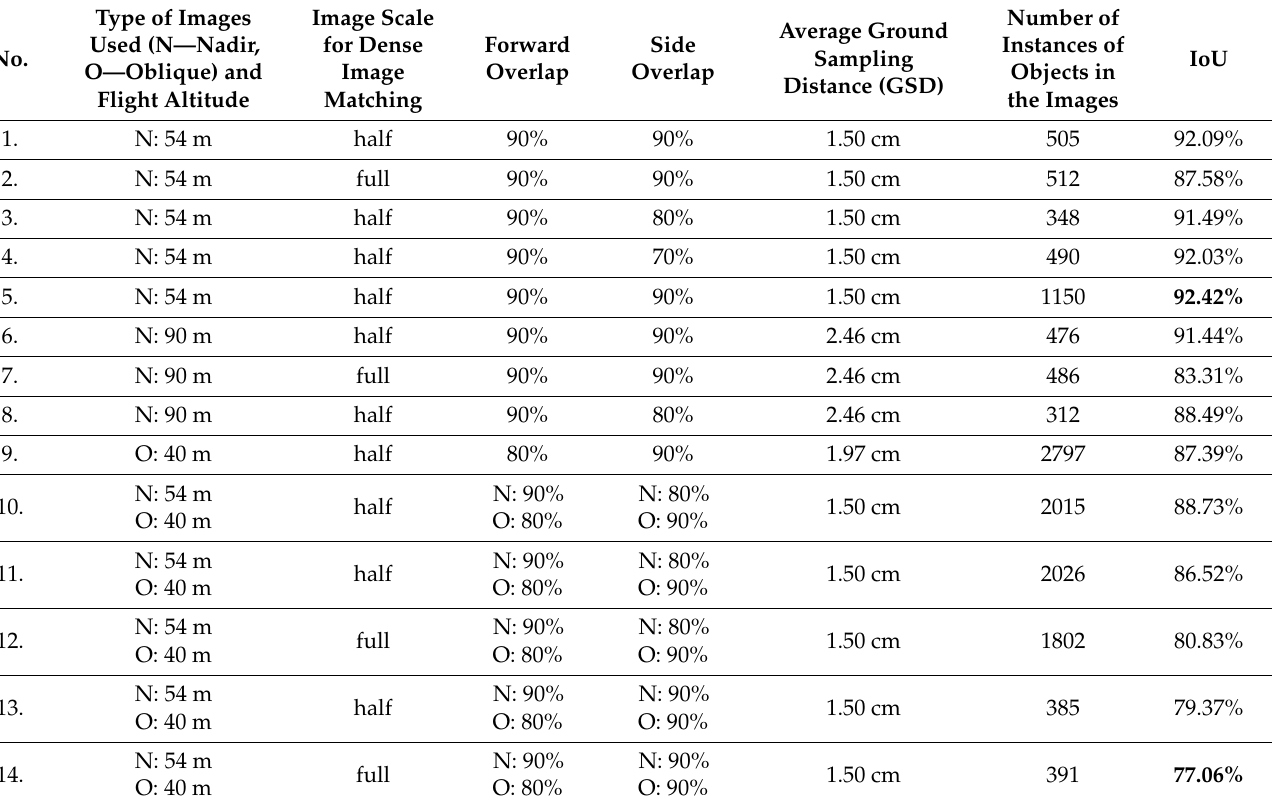
Table 7. Accuracies of the resulting bounding boxes for the gates for fourteen point cloud variants. The table values are the average IoU (Intersection over Union) multiplied by 100%, which is the evaluation